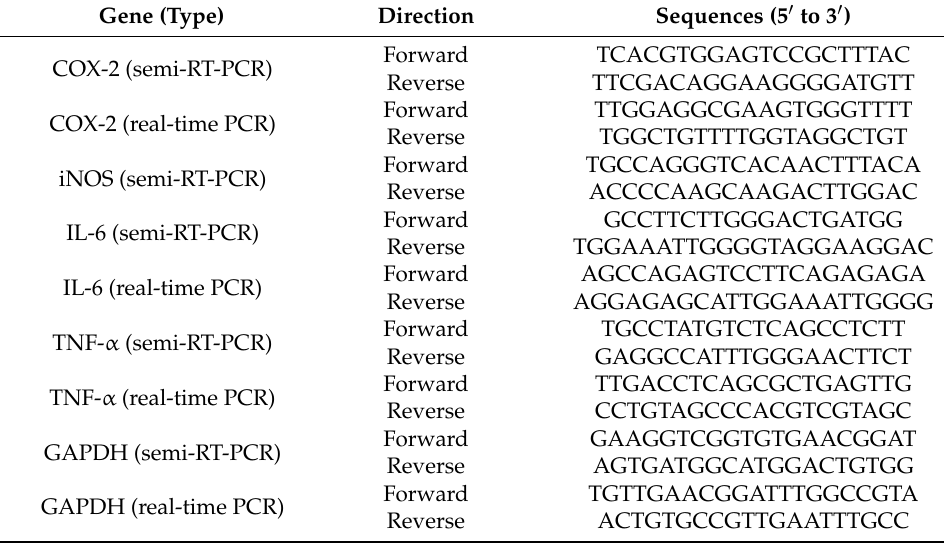
Table 2. Primer sequences used in analysis of mRNA expression levels of pro-inflammatory cytokine genes by semi-quantitative RT-PCR and quantitative real-time PCR. Gene (Type) Direction Sequences (5 (cid:48) to 3 (cid:48) ) Forward TCACGTGGAGTCCGCTTTAC COX-2 (semi-RT-PCR) Reverse TTCGACAGGAAGGGGATGTT Forward TTGGAGGCGAAGTGGGTTTT COX-2 (real-time PCR) Reverse TGGCTGTTTTGGTAGGCTGT Forward TGCCAGGGTCACAACTTTACA iNOS (semi-RT-PCR) Reverse ACCCCAAGCAAGACTTGGAC Forward GCCTTCTTGGGACTGATGG IL-6 (semi-RT-PCR) Reverse TGGAAATTGGGGTAGGAAGGAC Forward AGCCAGAGTCCTTCAGAGAGA IL-6 (real-time PCR) Reverse AGGAGAGCATTGGAAATTGGGG Forward TGCCTATGTCTCAGCCTCTT TNF- α (semi-RT-PCR) Reverse GAGGCCATTTGGGAACTTCT Forward TNF- α (real-time PCR) Reverse